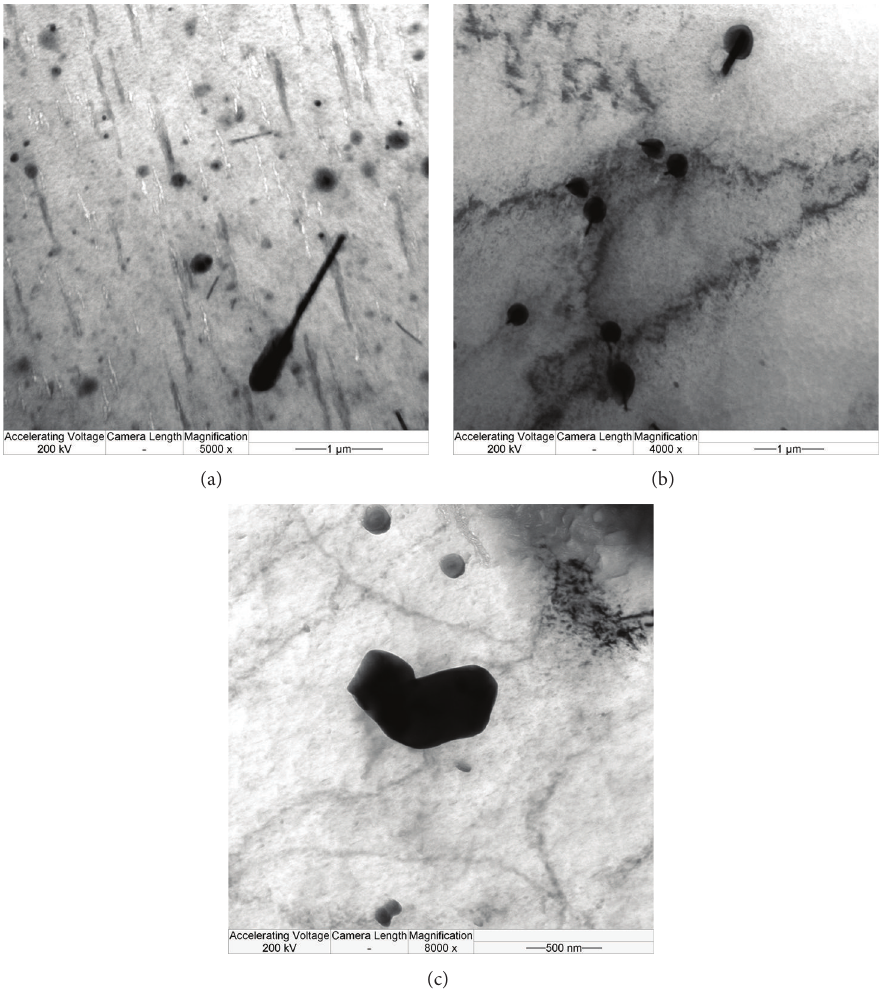
Figure 3: TEM morphology of the precipitates aged at 200 ∘ C for 8 h: (a) rod shape, (b) tadpole shape, (c) flake shape.